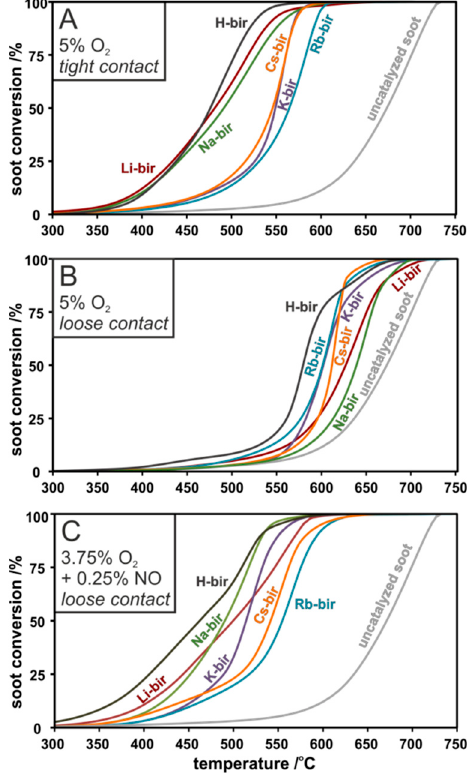
Figure 7. Soot conversion curves for birnessite containing various alkali cations in tight contact ( A ), loose contact ( B ), and loose contact with NO addition ( C ).